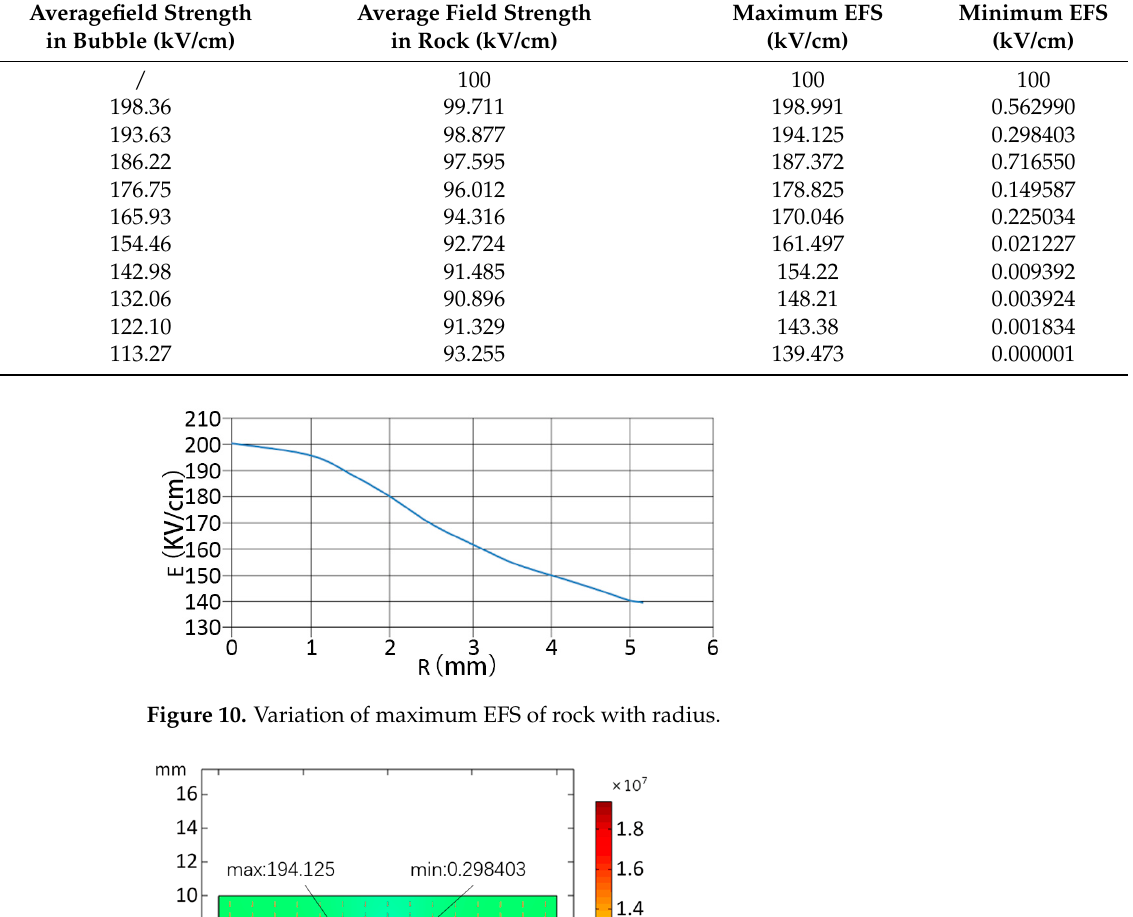
Table 2. Variation of EFS of rocks with distances between bubbles with the electric potential. Distance (mm)